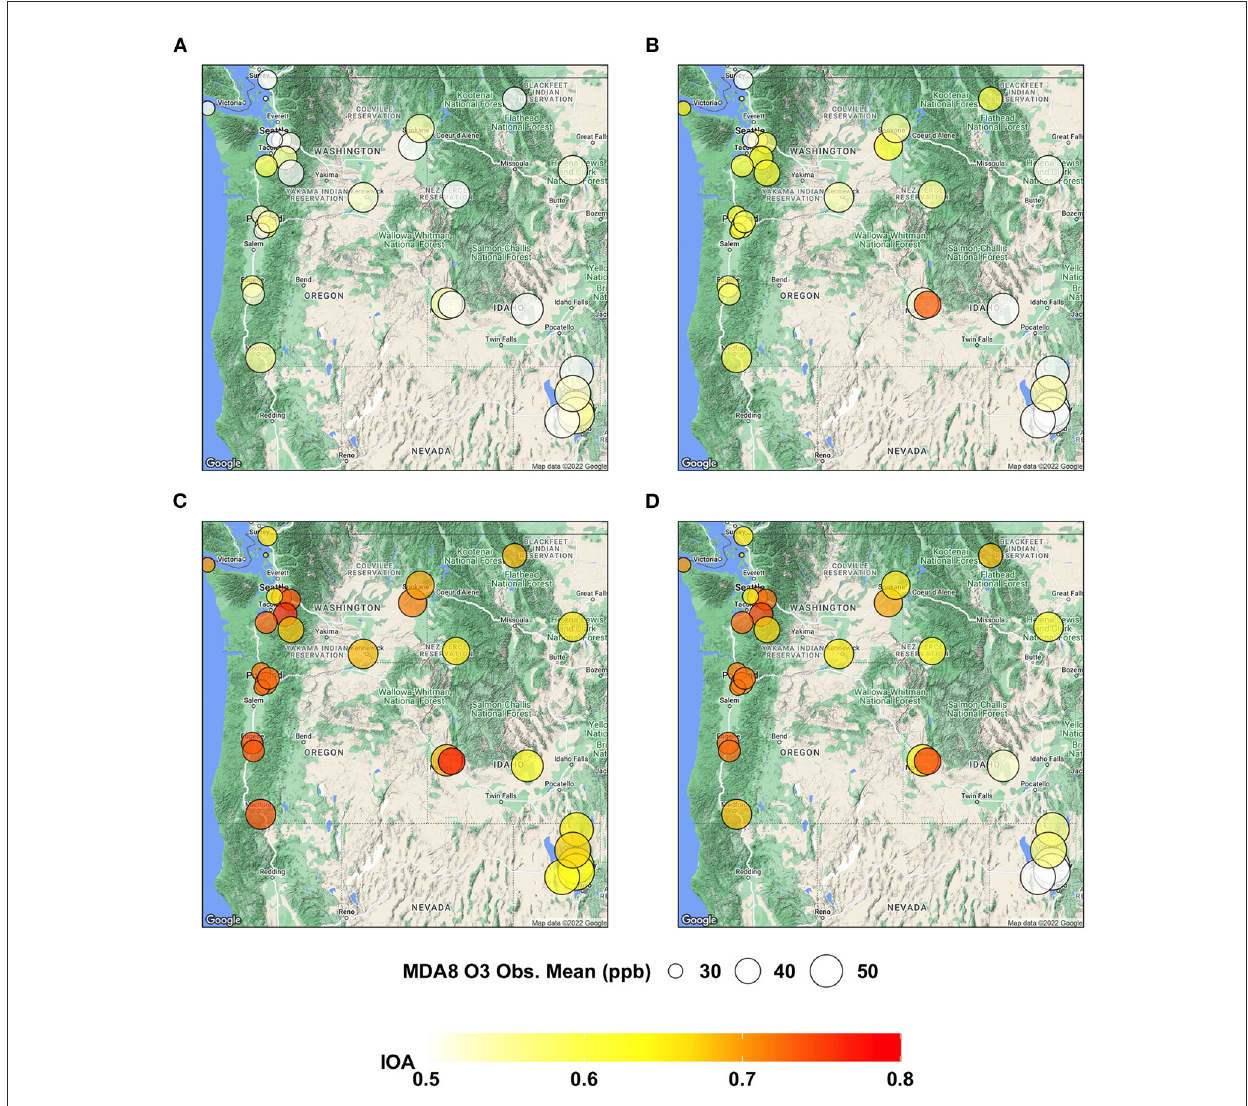
FIGURE4 Maps showing IOA of MDA8 O 3 predictions from (A) AIRPACT, (B) ML1, (C) ML2, and (D) ML_opr_O 3 at the AQS sites throughout the PNW.